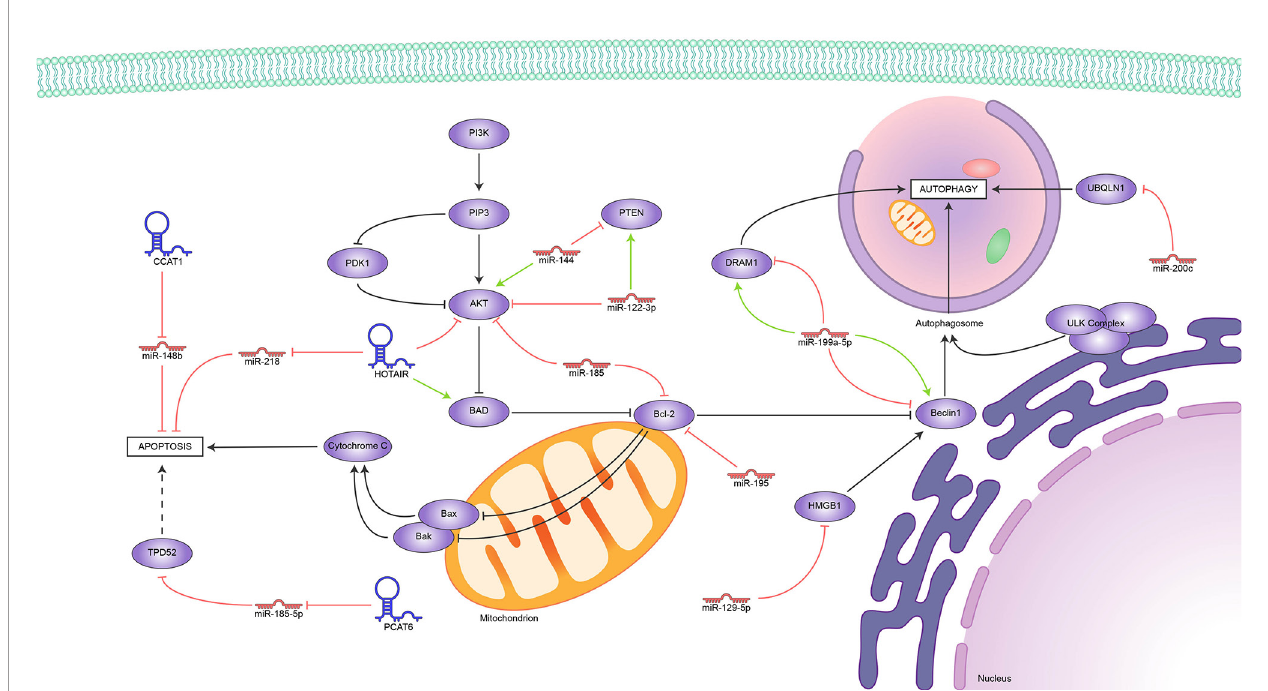
FIGURE 2 | Reported ncRNAs that regulate apoptosis, autophagy, and their targets. Green arrowheads represent positive regulation and red bars, negative